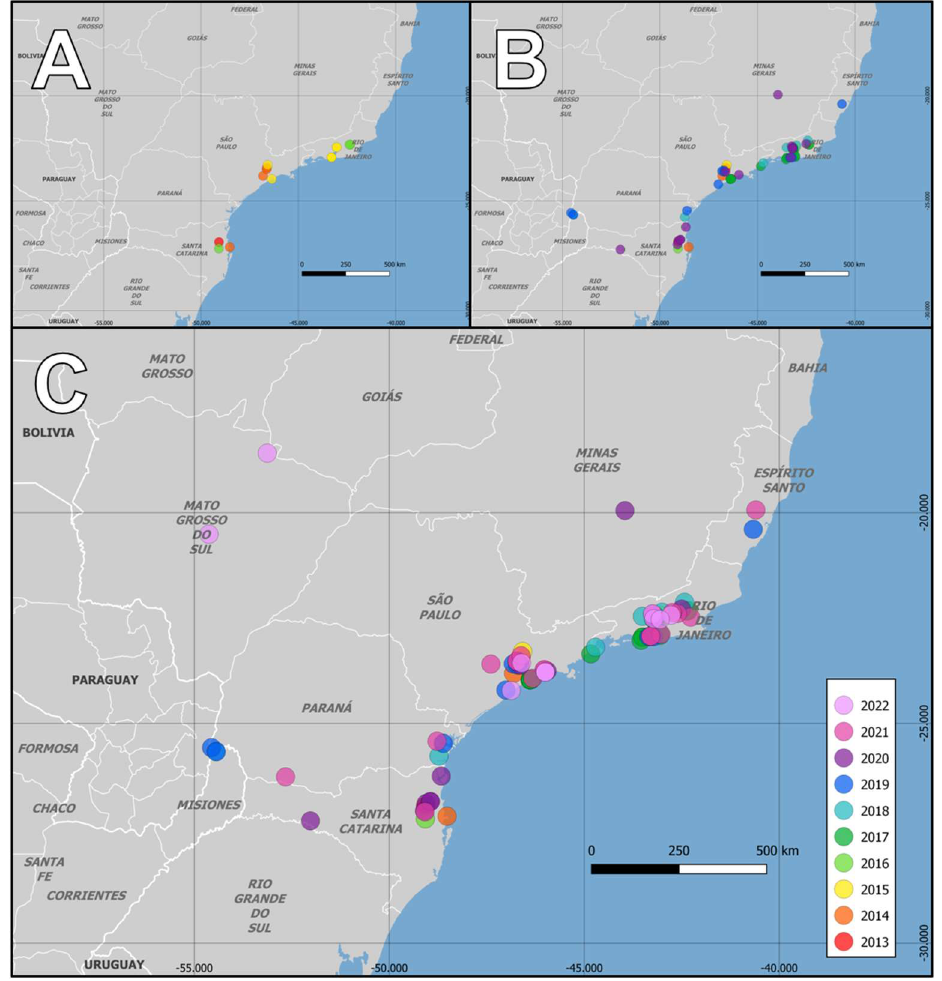
Figure 1. Maps showing the spread of Ovachlamys fulgens in Brazil through the years. ( A ). From 2013 to 2016. ( B ). From 2013 to 2020. ( C ). From 2013 to the present. The map was created with